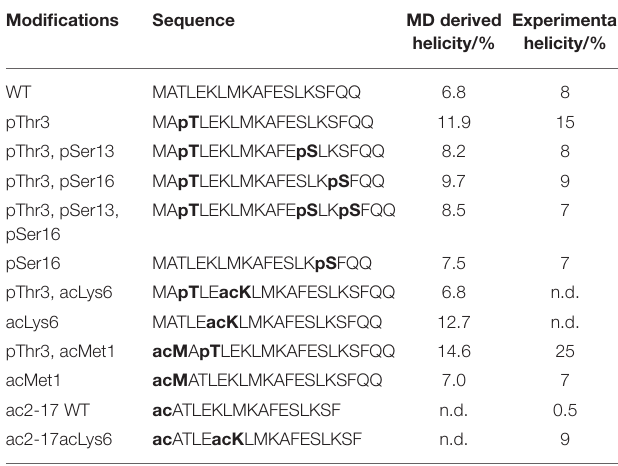
TABLE 1 | Experimental and simulation-derived helical content of the Htt1-19